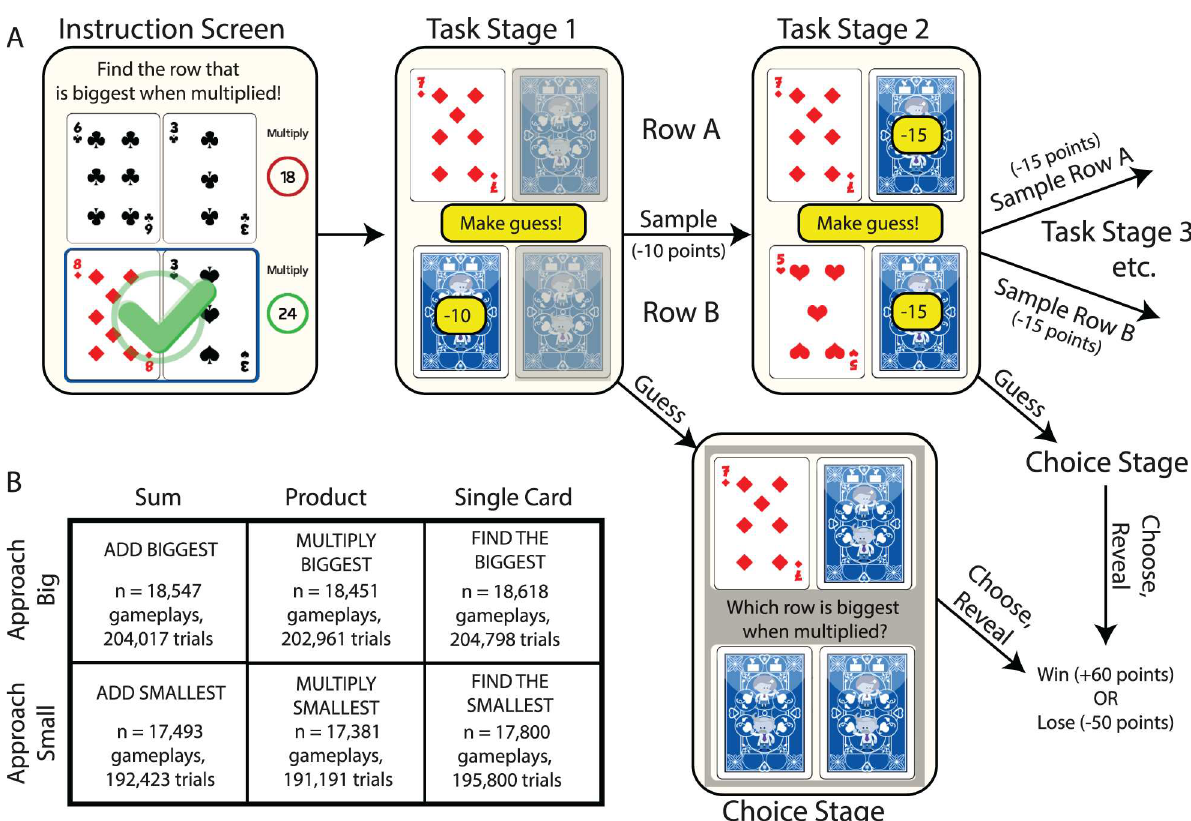
Fig 1. Information seeking task design. (A) Subjects aim to select the “winningrow” (in this example, the row with the largest product). After the first card is revealed (here, the 7 of diamonds),subjects enter Task Stage 1. Here, they choose between the two yellow options, either samplinganother card (costing 10 points) or making a guess about which is the winningrow (no cost). Greyed-out cards cannot yet be sampled. If choosingto sample, then Task Stage 2 is entered, in which either remainingcard may be sampled (costing 15 points) or the subject may again guess. In Task Stage 3, samplingthe last remaining card costs 20 points. At any Task Stage, making a guess means that subjects enter the Choice Stage. Here, after choosing, all cards are revealedand the subjected either wins 60 points if correct, or loses 50 points if incorrect. (B) The six task conditions in a 3-by-2 design. Subjects either select the row with biggest (or smallest) sum, the biggest (or smallest) product, or the biggest (or smallest) single